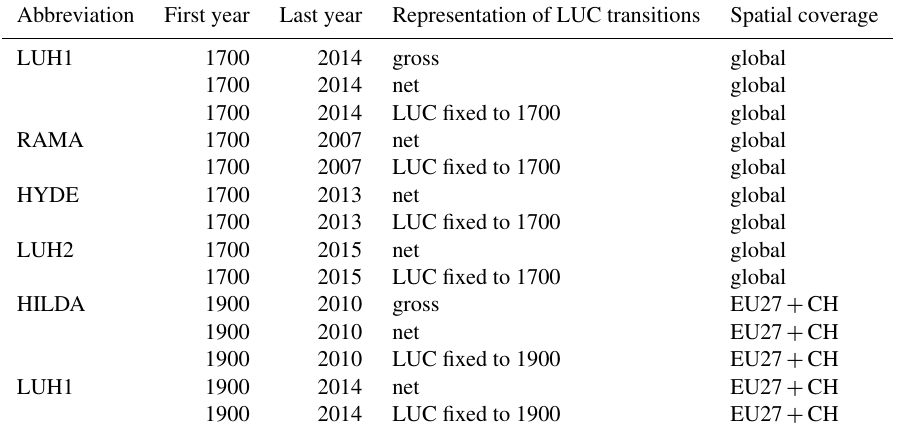
Table 2. Overview of LPJ-GUESS simulations carried out as part of this study. Abbreviation First year Last year Representation of LUC transitions Spatial